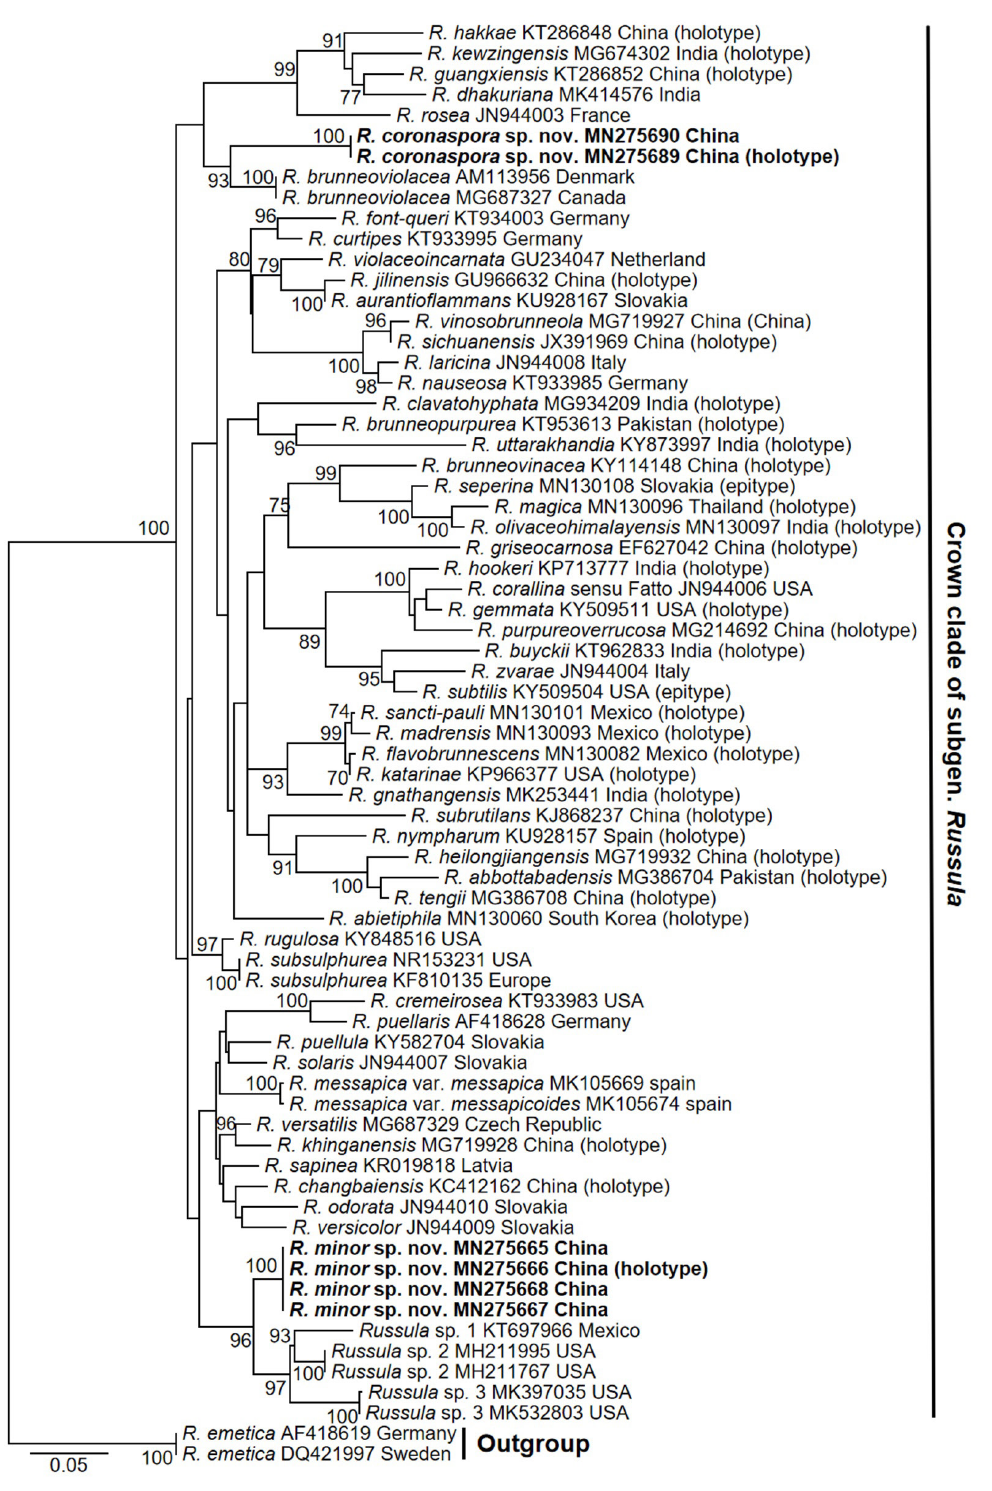
Fig. 1. Maximum Likelihood tree of subgen. Russula crown clade based on ITS sequences, bootstrap values higher than 70% were displayed around nodes. Accession numbers of the two novel species are shown in